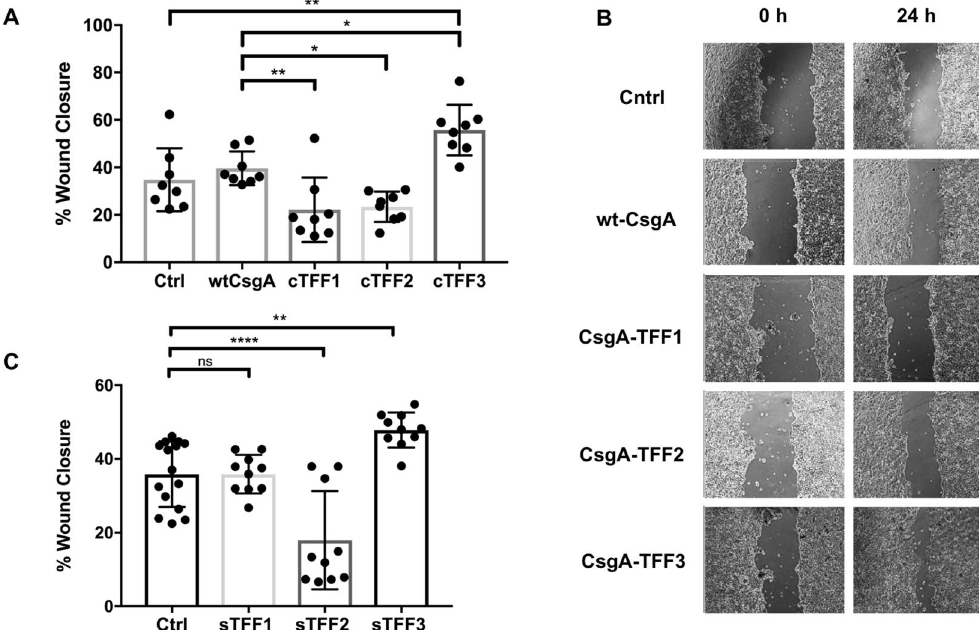
Figure 4. Bioactivity of displayed trefoil factors on the curli matrix ( A ). Percent cell monolayer defect closure for Caco-2 cell monolayers during incubation with various soluble semi-purified curli variants. Bars represent mean % defect closure after 24 hours. Ctrl indicates scratched Caco-2 monolayers with no treatment. ( B ) Representative images of defects and their progressive closure after 24 hours in the presence of various curli fiber variants. ( C ) Corresponding cell migration assay with soluble trefoil factors. Ordinary one way Anova n = 10, ** P < 0.01, *** P < 0.001 Ordinary one way ANOVA with Dunnett’s multiple comparison test n = 10, * P < 0.05, ** P < 0.01, *** P < 0.001, **** P <